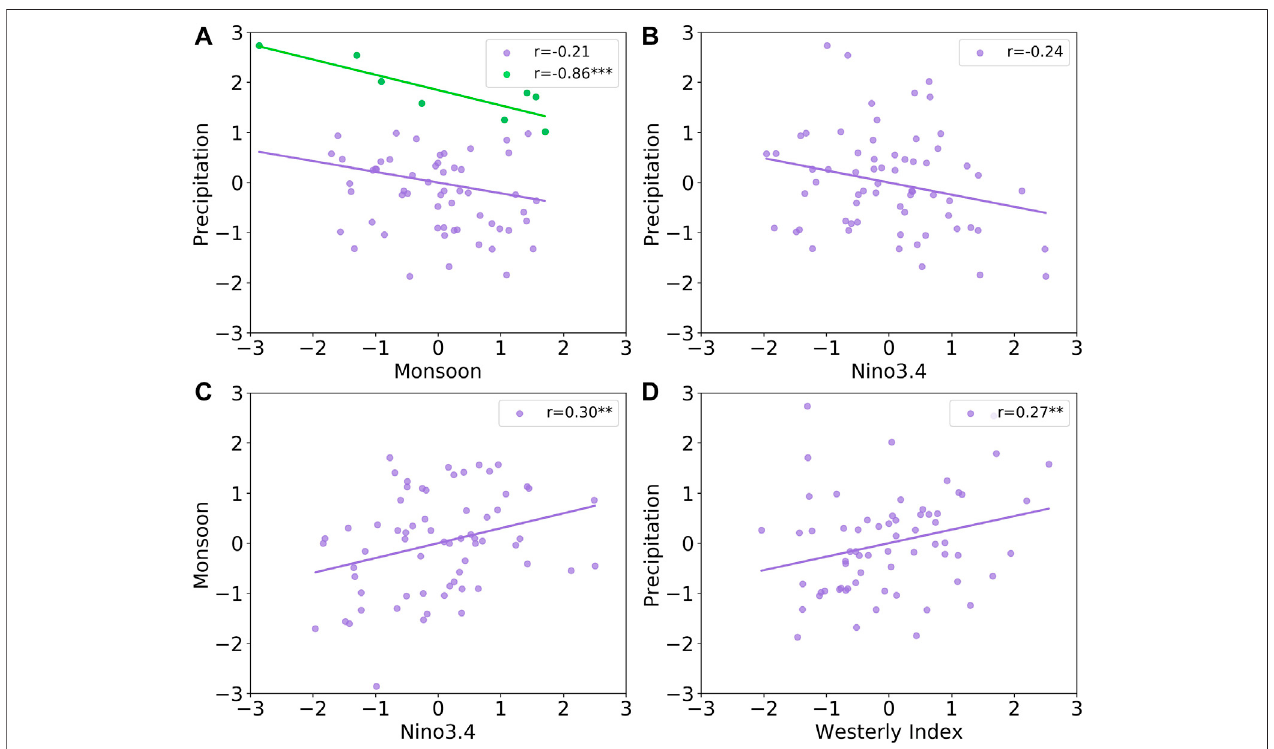
FIGURE7| Correlationcoef fi cientsbetweenprecipitationandthemonsoonindex (A) ,precipitationandNiño3.4 (B) ,andNiño3.4andthemonsoonindex (C) .The green dots in (A) represent the years when the monsoon edge crossed the semi-arid regions. Two asterisks denote statistical signi fi cance at the 95% con fi dence level based on Student ’ s t-test. Three asterisks denote statistical signi fi cance at the 99% con fi dence level based on Student ’ s t-test.